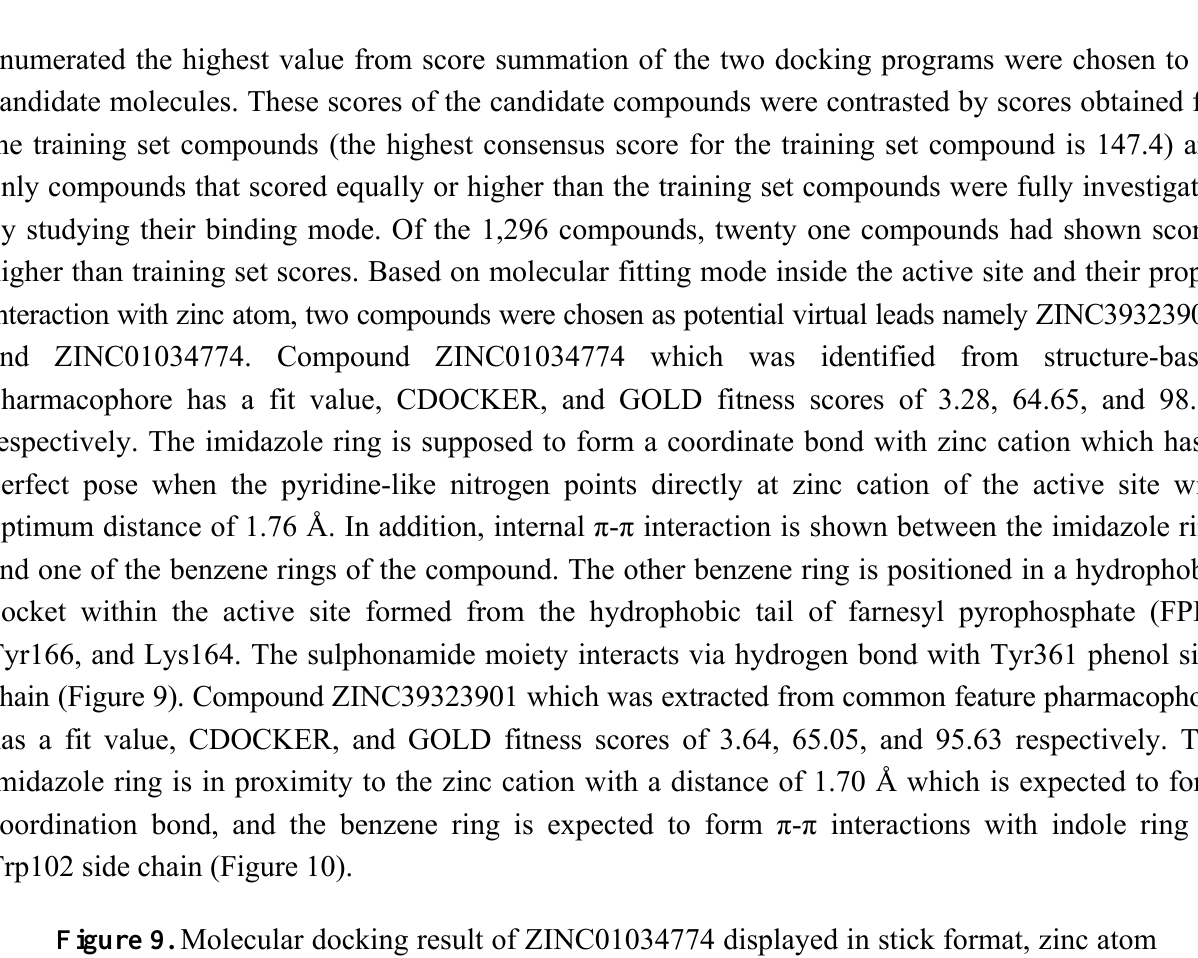
Figure 9. Molecular docking result of ZINC01034774 displayed in stick format, zinc atom CPK and active site amino acids presented as line